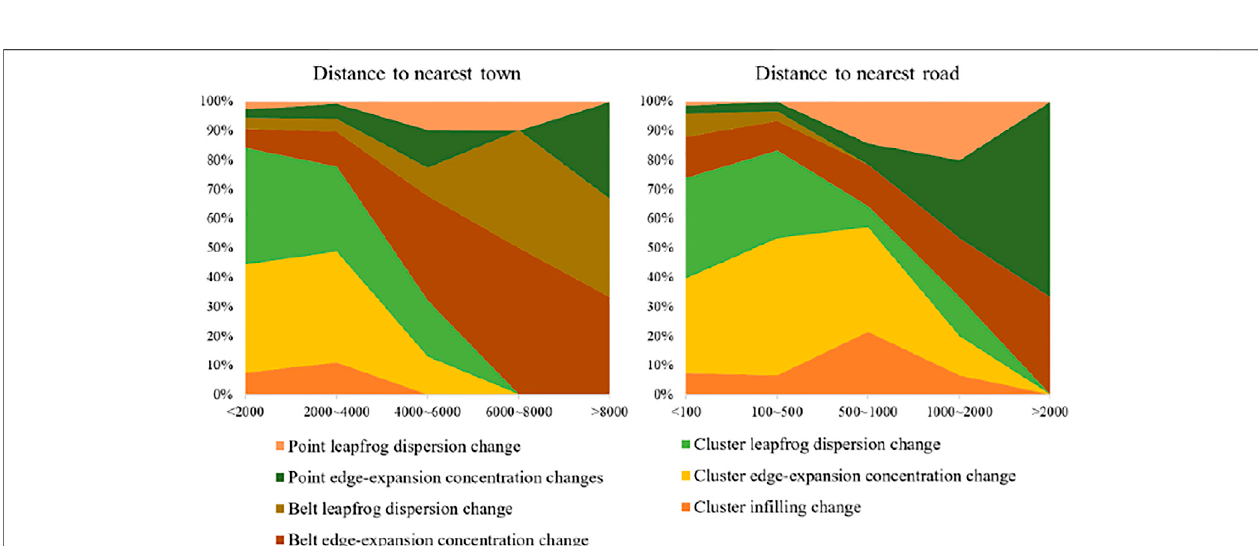
FIGURE 9 | Distribution characteristics of the dynamic spatial pattern of RRL under the topography gradient.